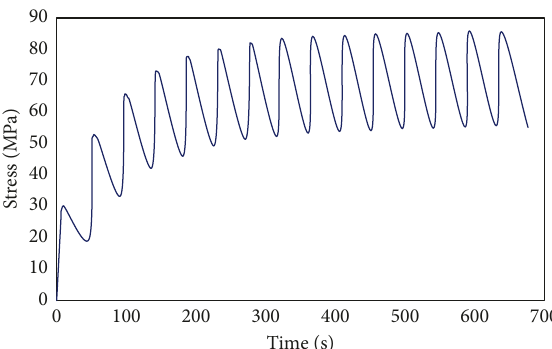
Figure 21: Thermal stress change curve of disc surface in repeated